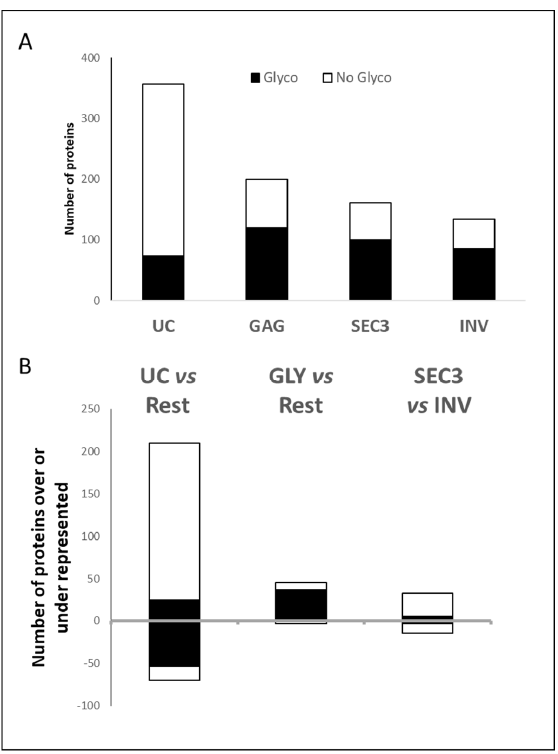
Table 2. GO Cell Component analysis of proteins enriched using GAG vs. preparations obtained with the rest of techniques. Red color denotes enrichment in GAG